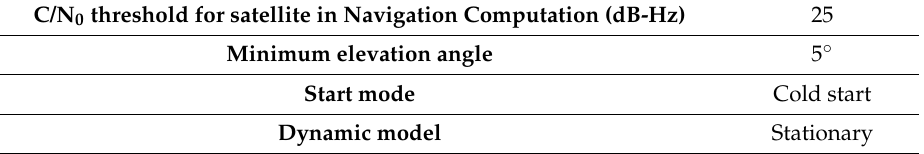
Table 2. Receiver